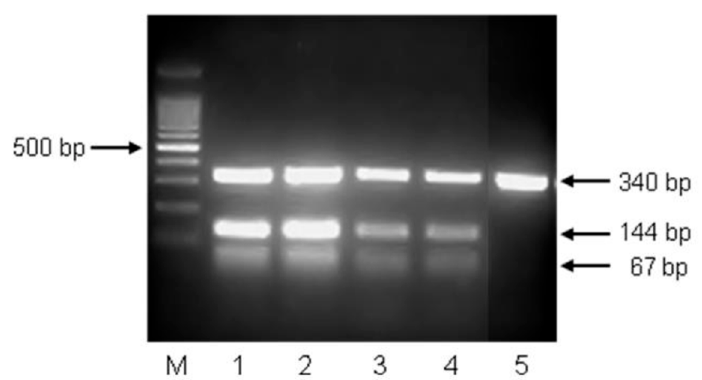
Figure 3. Molecular identification of L. casei ATCC 393 in yogurts after 28 days of refrigerated storage. Lane 1: pure culture of L. casei ATCC 393; Lane 2: probiotic yogurt with immobilized L. casei ATCC 393 cells on casein; Lane 3: probiotic yogurt with immobilized L. casei ATCC 393 cells on apple pieces; Lane 4: probiotic yogurt with free L. casei ATCC 393 cells; Lane 5: yogurt without L. casei ATCC 393 cells. PCR products of 67 and 144 bp are unique for L. casei ATCC 393, whereas the PCR product of 340 bp is universal for lactobacilli.